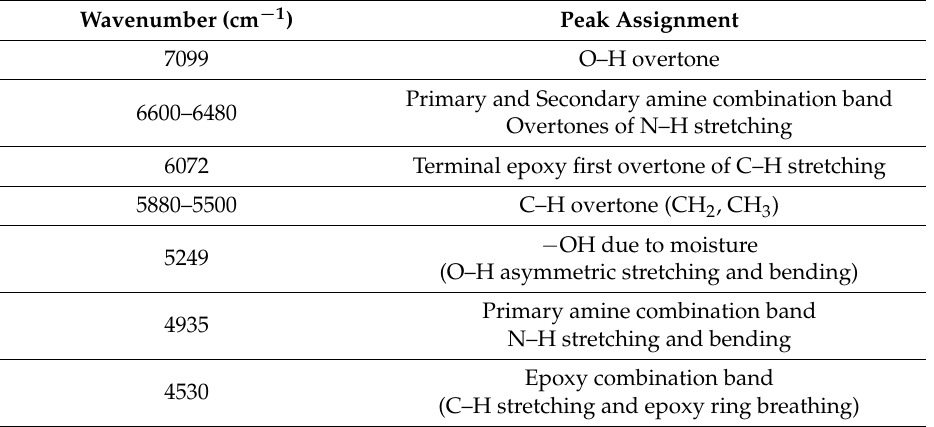
Table 5. Near infrared (IR) Band Assignments of PPO-Jeffamine